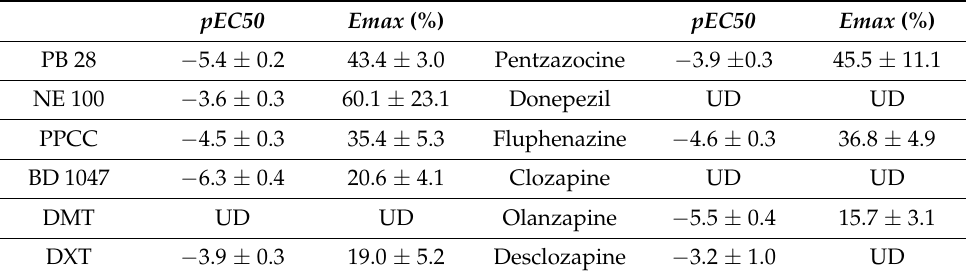
Table 2. Potency (pEC50) and maximum effect (Emax) calculated for each drug on superoxide formation evoked by NADH dehydrogenase activity in isolated bovine heart membranes.